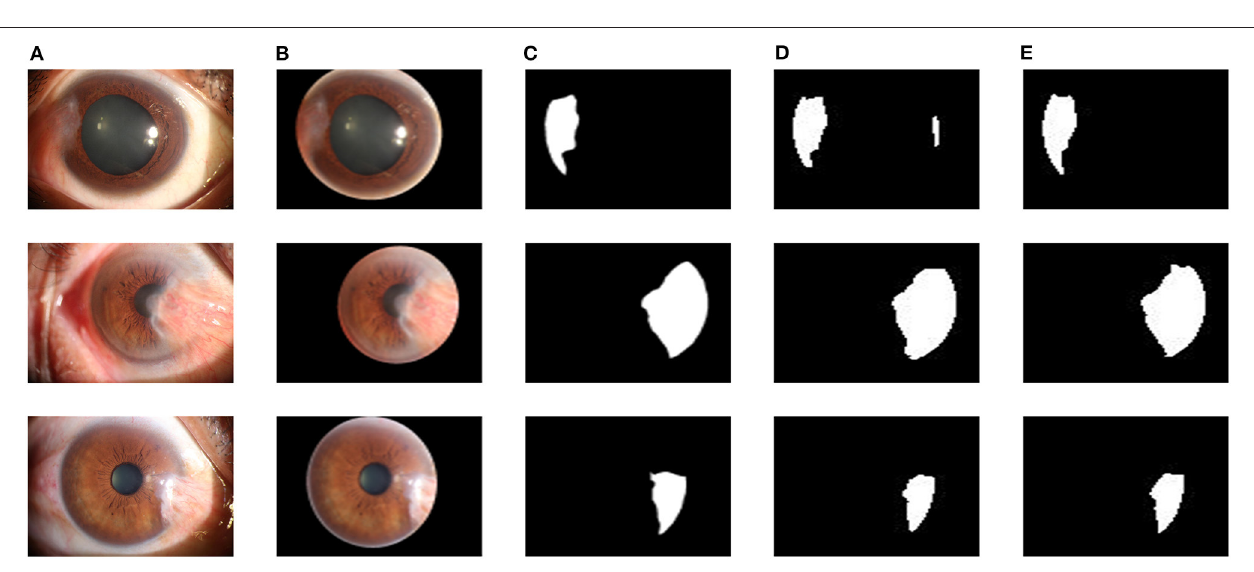
The improved U-Net ++ is used in the